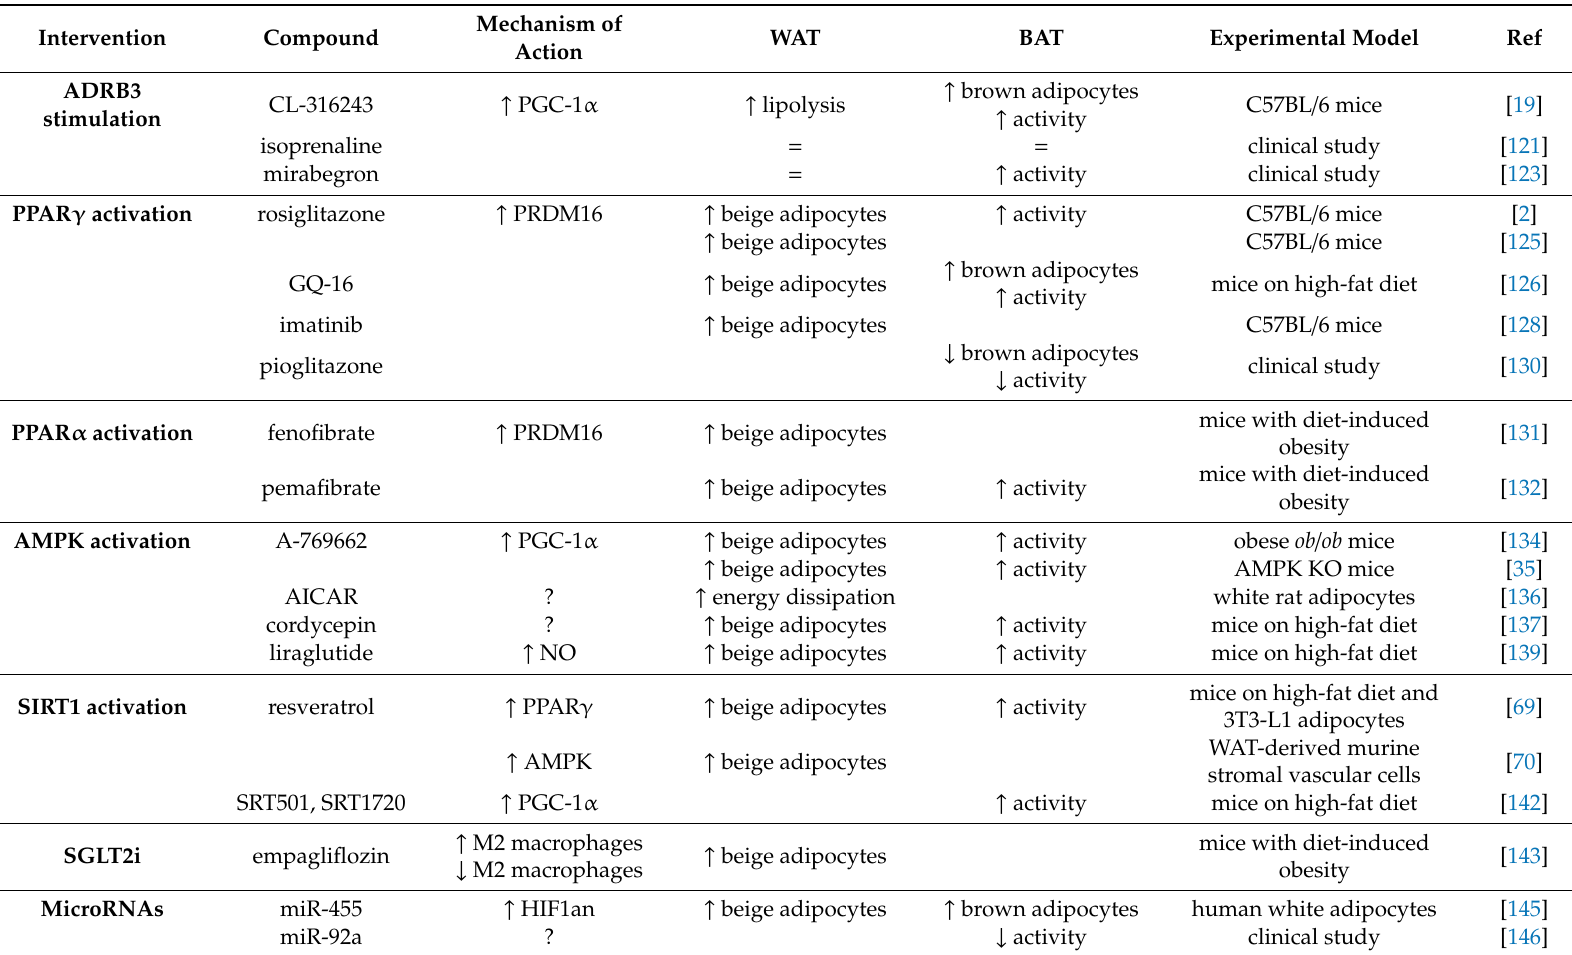
↑ increase / enhancement; ↓ decrease / reduction; ? unknown mechanism; ADRB3—adrenergic receptor beta 3; AICAR—5-aminoimidazole-4-carboxamide-1- β